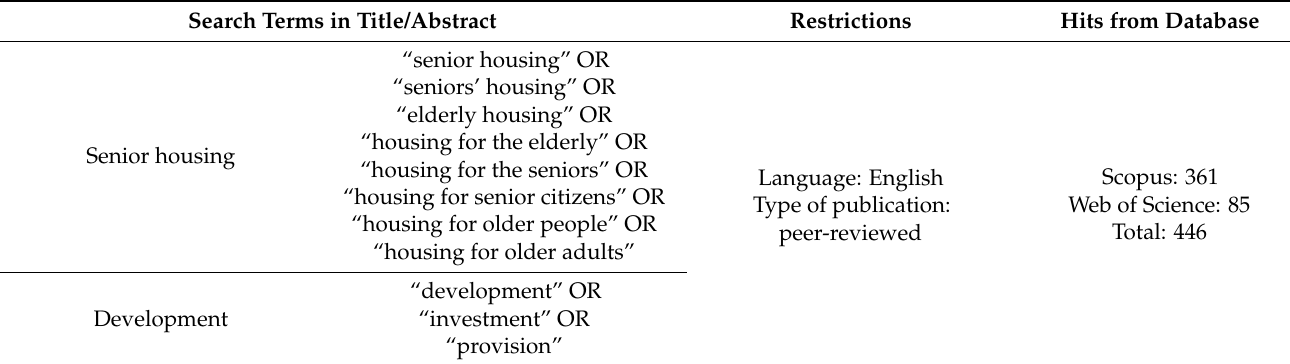
Table 1. Searching strategies for peer-reviewed